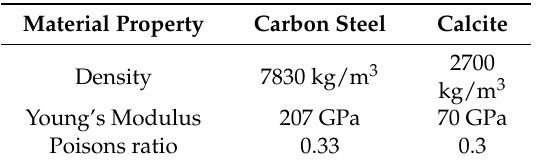
Table 2. Assumed material property of steel and Calcite for the Finite Element